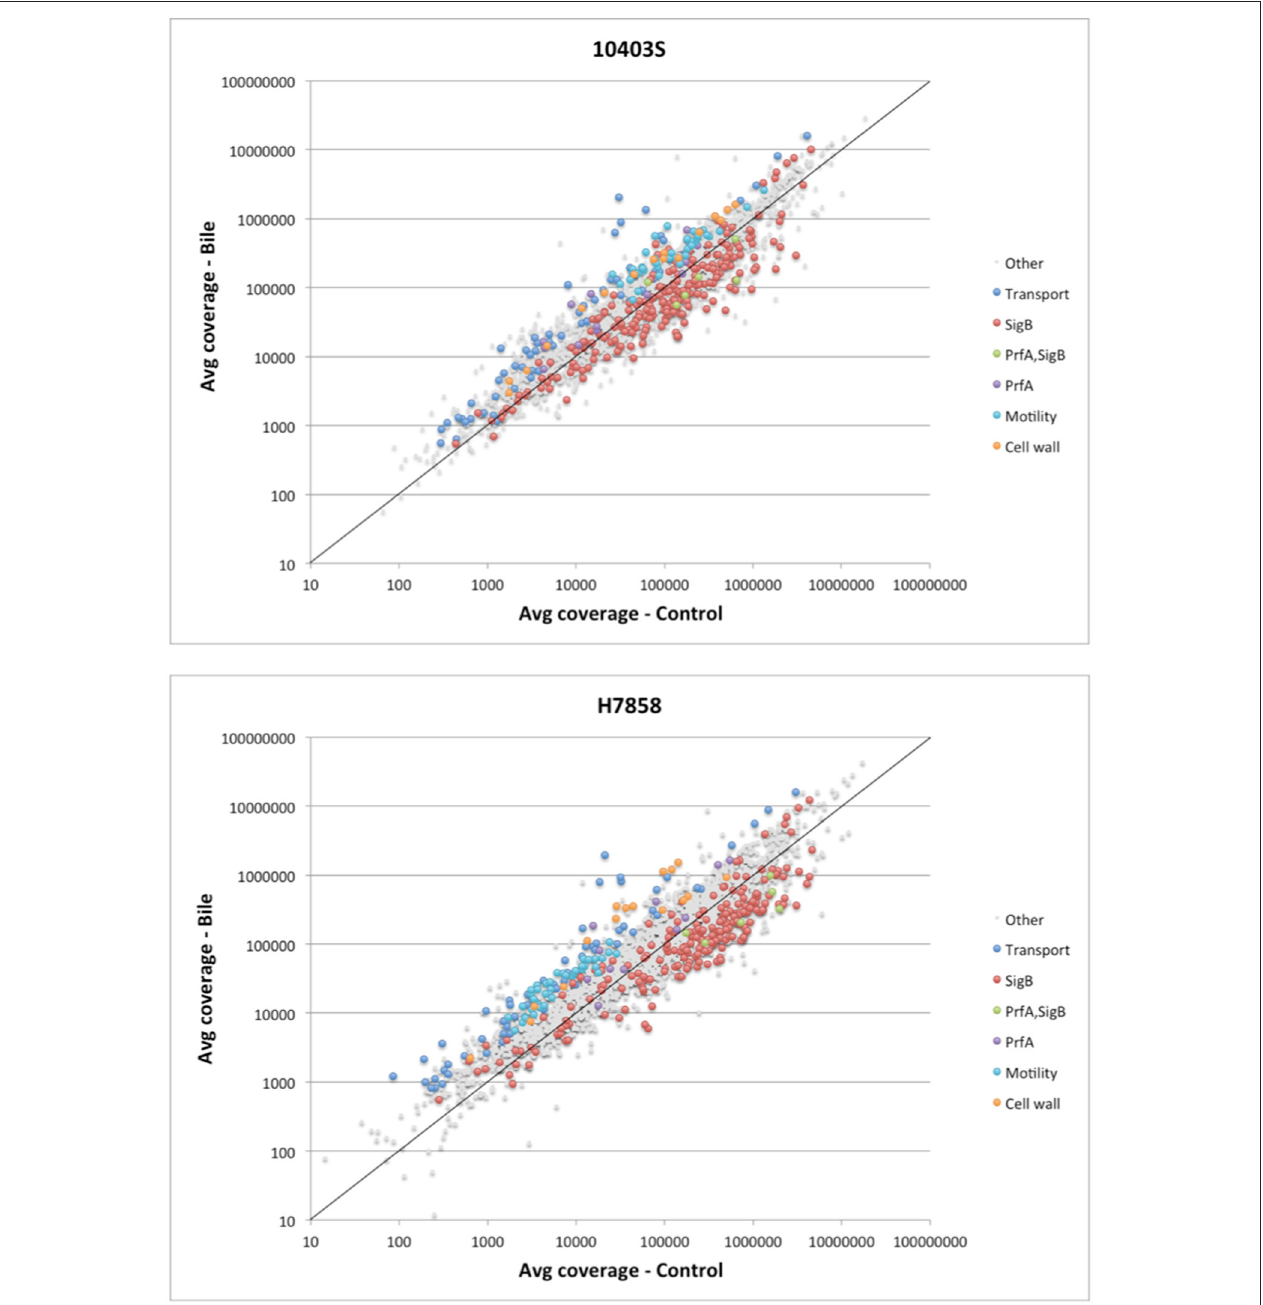
FIGURE 2 | Analysis of differential expression on the RNA-seq data of L. monocytogenes exposed to pH 5.5 with and without bile. Scatterplot representing the average expression level of genes exposed to pH 5.5 with bile (Y axis) vs. without bile (X axis) in L. monocytogenes 10403S (Top) and H7858 (Bottom). The known regulons of SigB and PrfA are labeled, as well as the significantly upregulated genes belonging to transport, cell wall, and motility related functions. The x = y line is shown in solid black, indicating a ratio of one (non-differentially expressed).